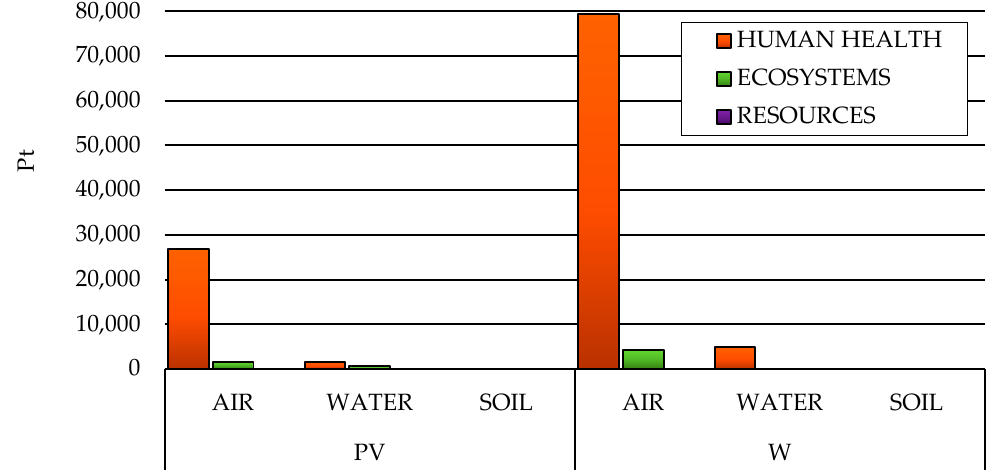
Figure 8. Grouping and weighting results of environmental effects for areas of influence, with consideration of compartments, present in the life cycle of wind (W) and photovoltaic (PV) power plants (unit: Pt).